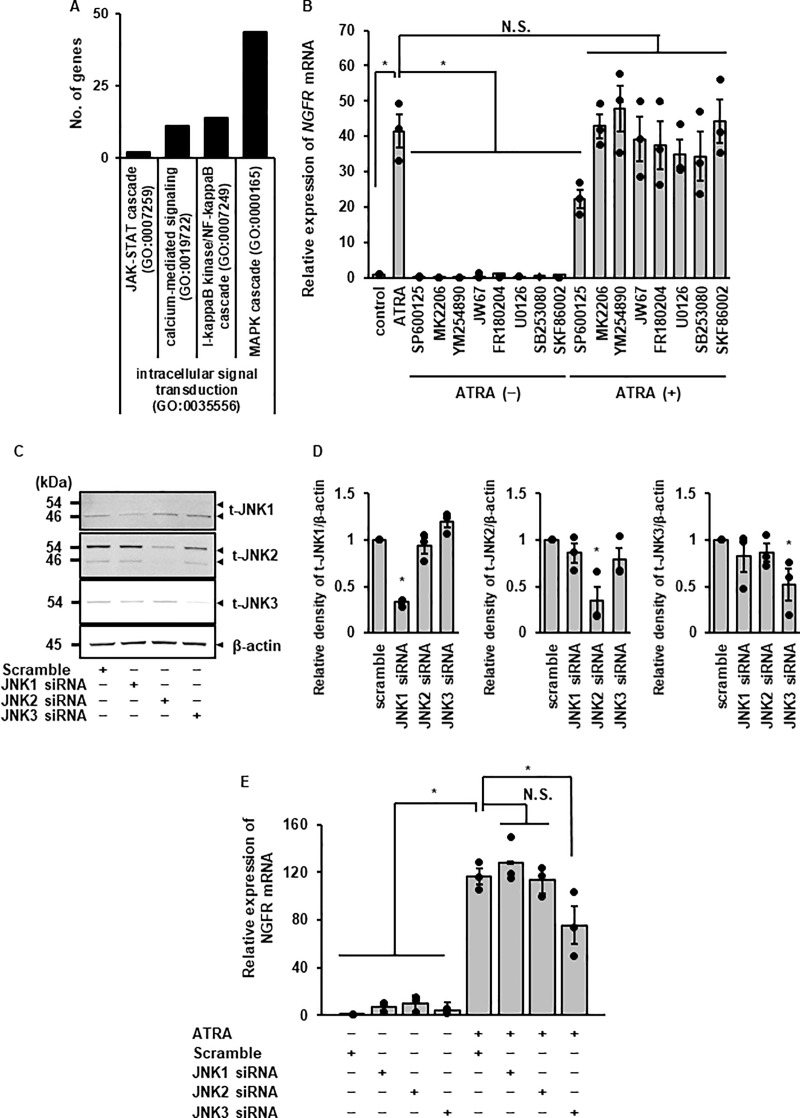
Contribution of JNK subtype to ATRA-induced neuronal reprogramming.(A) Pathway analysis showing the number of differentially expressed genes (P < 0.05) under GO terms of intracellular signal transduction. (B) The effect of inhibitors on ATRA-induced expression of NGFR. Data are shown as the mean ± standard error of three independent experiments. *P < 0.05. (C to D) Protein expression of JNK1, 2, and 3 in JNK1, 2, or 3 siRNA-transfected cells. JNK1, 2 or 3 siRNA transfection resulted in a significant decrease in the expression of JNK1, 2, or 3 protein, respectively, but not scramble siRNA transfection (C). The relative density of JNK1, 2, or 3 protein expression in siRNA-transfected cells compared with scramble siRNA-transfected cells is illustrated (D). β-actin was used as an internal standard. Data are shown as the mean ± standard error of 3 independent experiments. *P < 0.05. (E) Decrease in ATRA-induced NGFR mRNA expression in cells transfected with JNK3 siRNA, but not in those transfected with JNK1 or 2 siRNA. Data are shown as the mean ± standard error of three independent experiments. *P < 0.05.